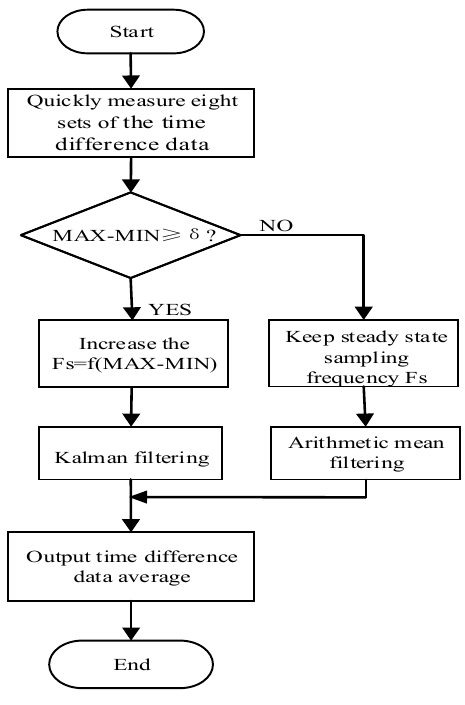
Figure 8. Data-filtering algorithm.